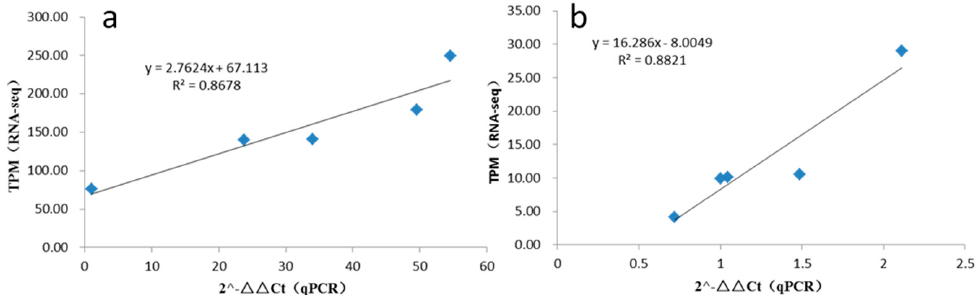
Figure 7. The linear relationship between RNA-seq and qRT-PCR: ( a ) It was qRT-PCR for Chr11:1679797|1735868. ( b ) It was qRT-PCR for Chr01:21162287|21214009.